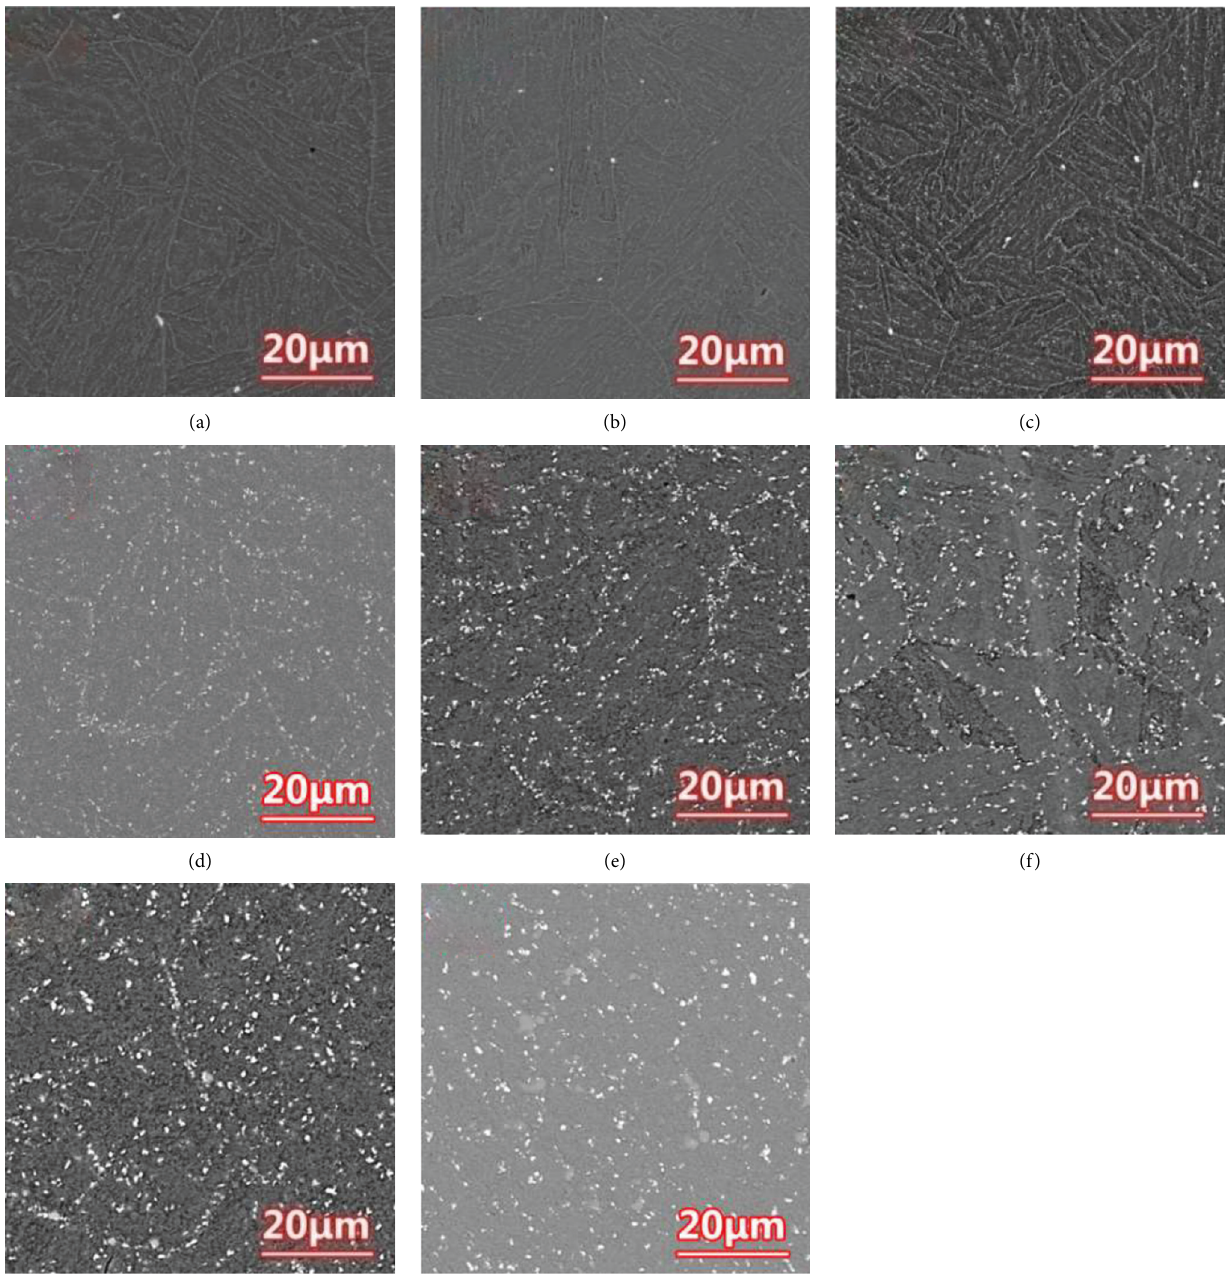
Figure 6: Typical SEM images of G115 steel after aging at 650 ° C (a–d) and 700 ° C (e–h) for different times: (a, e) 500 h; (b, f) 1000h; (c, g) 3000h; (d, h) 5000h.